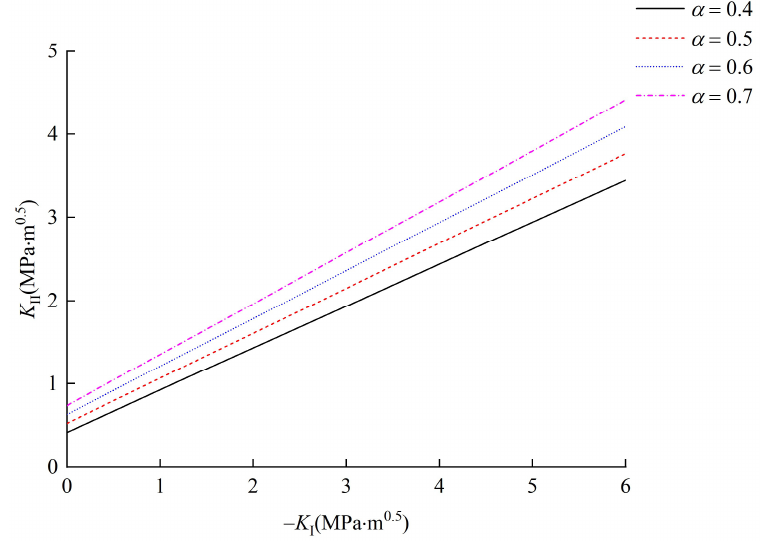
Figure 12. Effect of α on the initiation of interface crack.